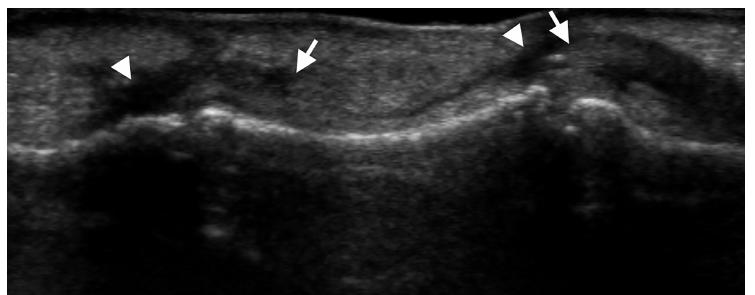
Fig 2. A 49-year-old woman with a flexor digitorum profundus tendon rupture of the ring finger. Ultrasound image of longitudinal scan shows discontinuity of the tendon with retraction of the ruptured tendon (arrows) at the middle phalangeal level. Anechoic lesions are seen around the ruptured tendon stumps and within the tendon sheath (arrowheads).